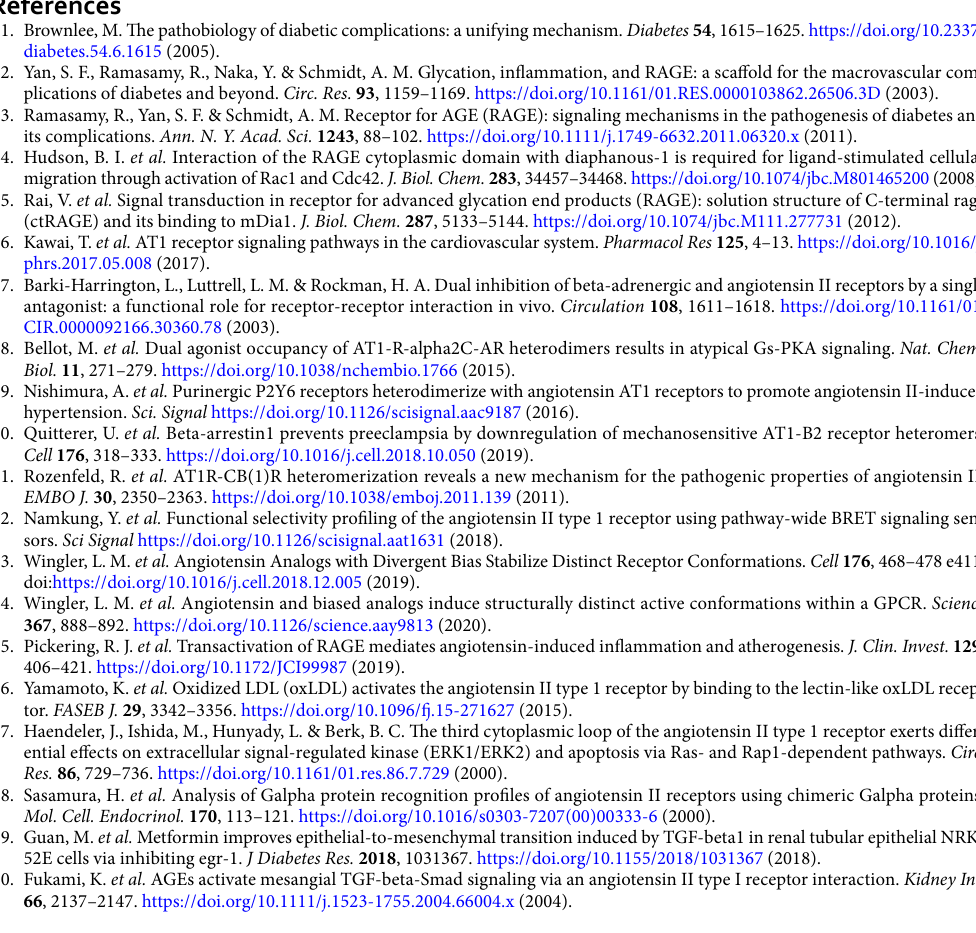
Figure 3. AGE-BSA induces the AT1-dependent signaling cascade in rat kidney epithelial cells. ( a ) Immunoblot analysis of phosphorylation of ERK in response to 100 µg/mL BSA, Ang II or AGE-BSA for 5, 15,30, or 60 min with or without 1 µM olmesartan (AT1 blocker, ARB) in NRK52E cells. The graph indicates the intensity ratio of phosphorylated ERK (P-ERK) /total ERK(T-ERK) normalized to that with vehicle control (number(n) = 1, Ang II, n = 4, the other groups). * p < 0.05 determined by Student’s t -test. ( b ) Confirmation of knockdown efficiency of siRNA by quantitative real-time PCR in NRK-52E. (n = 5, each) The expression level of each gene was normalized using GAPDH mRNA as an internal control. The differences were determined by one-way ANOVA with Bonferroni correction. * p < 0.01 vs scramble siRNA; ♰ p < 0.05 vs scramble siRNA. ( c ) Immunoblot analysis of phosphorylation of ERK in response to 100 µg/mL BSA or AGE-BSA for 30 min in combination with siRNA of scramble, RAGE or AT1 in NRK52E cells. The graph indicates the intensity ratio of P-ERK /T-ERK normalized to that with vehicle control (n = 4, each). The differences were determined by one-way ANOVA with Bonferroni correction. * p < 0.01 vs. scramble siRNA treated with BSA. ( d ) NF-κB luciferase reporter assay performed employing a treatment regimen of 50 μg/mL BSA or AGE-BSA for 2 h on treatment with 1 μM olmesartan (ARB) or 1 μM FPS-ZM1 (RAGE inhibitor) (n = 4, each). The differences were determined by one-way ANOVA with Bonferroni correction. * p < 0.01 vs. AGE-BSA treatment; ♰ p < 0.05 vs. AGE-BSA treatment. ( e ) cAMP concentration in response to vehicle ,0.3 µg/mL HMGB1, 100 µg/mL AGE- BSA, or 10 –10 M angiotensin II after the treatment with the indicated siRNA in NRK52E (n = 10, each). The concentration in vehicle-treated wells in cells with siVehicle was normalized to 100%. The differences were determined by one-way ANOVA with Bonferroni correction. * p < 0.01 vs. vehicle treatment; ♰ p < 0.05 vs. vehicle treatment. ( f , g ) Immunoblot analysis of α-smooth muscle actin (SMA) as a measure of epithelial– mesenchymal transition after stimulation with ( f ) 100 μg/mL BSA, 100 μg/mL AGE-BSA, ( g ) vehicle, 3 µg/mL HMGB1, or 20 ng/mL TGFβ for 72 h. (n = 4, each). Treatment with 1 μM losartan (ARB), or irbesartan (ARB) was carried out 24 h before stimulation. The graph indicates the intensity ratio of α-SMA /control α-tubulin normalized to that with BSA (f) or vehicle ( g ). The differences were determined by one-way ANOVA with Bonferroni correction. * p < 0.05 vs. the other treatments; ♰ p < 0.05 vs. vehicle treatment. Full-length blots are presented in Supplementary Fig.